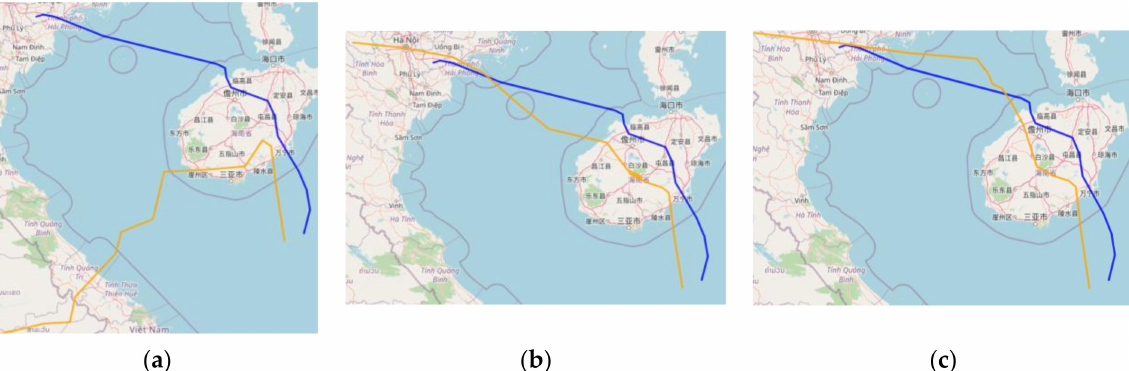
Figure 6. Comparison of the real and predicted paths of Typhoon “Lionrock” under different iterations, where the blue path indicates the actual path of the typhoon and the orange path indicates the path predicted by the model. ( a ) The path comparison when the number of iterations is 25, ( b ) the path comparison when the number of iterations is 50, ( c ) the path comparison when the number of iterations is 100. p.s. The left side of the ocean represents Vietnam, where the non-English text indicates different cities in Vietnam; the right side of the ocean represents Hainan, China, where the non-English text indicates different cities in